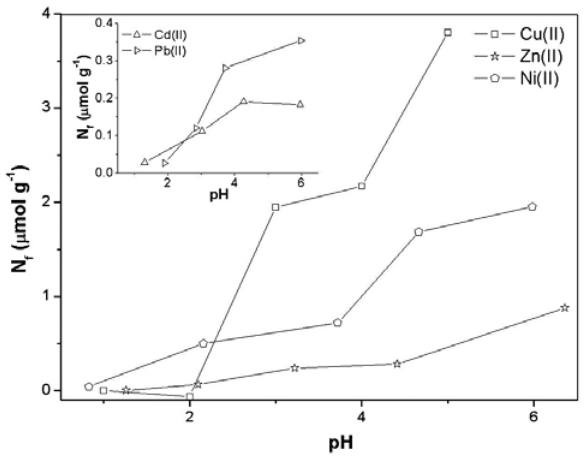
Figure 6. pH effect over the adsorption of Cu(II), Cd(II), Zn(II), Pb(II), and Ni(II).